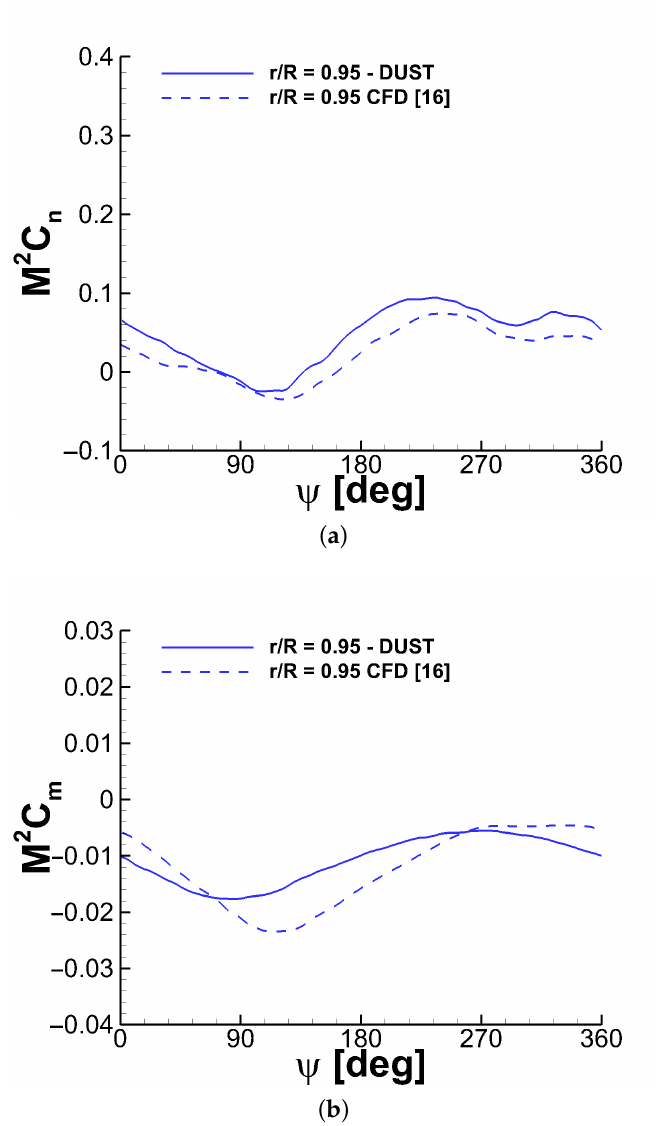
Figure 21. Comparison of the time histories of the non-dimensional normal force M 2 c n and pitching moment M 2 c m on the proprotor blade in conversion flight condition at r / R = 0.95, θ N = 60 ◦ , V ∞ = 100 kts, Ω = 589